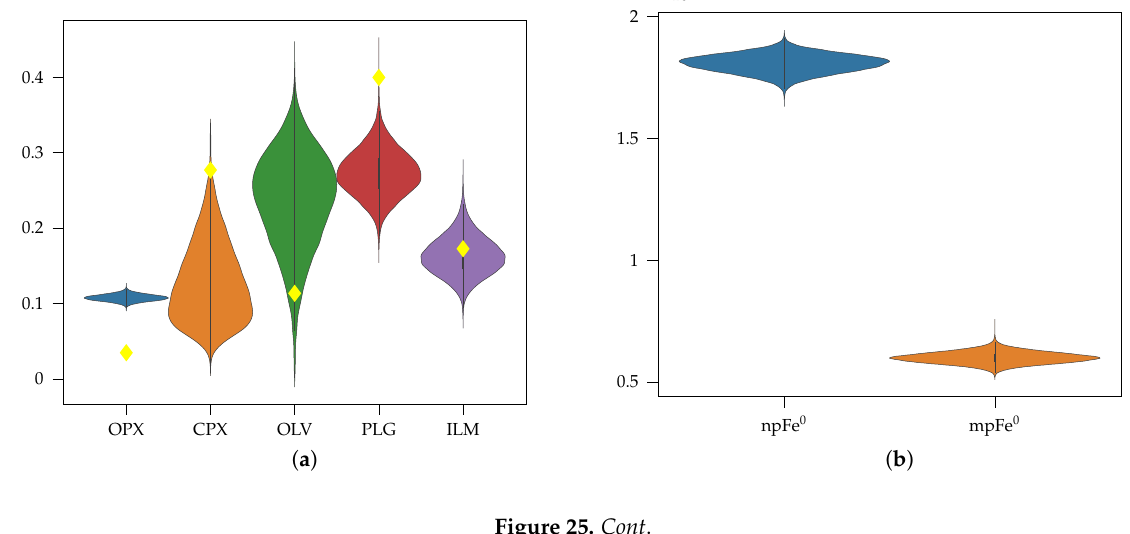
Figure 24. Results for LSCC sample 62231 with Ti/Al prior. This LSCC sample is a mature ( I s /FeO = 116.7) highland spectrum. There are almost no absorption bands visible. Yellow diamonds mark the true mineral fractional abundances. The mean predicted values are close to the theoretical mineral abundances. ( a ) Endmember abundances (62231); ( b ) smFe abundances (62231); ( c ) smFe abundances (62231).